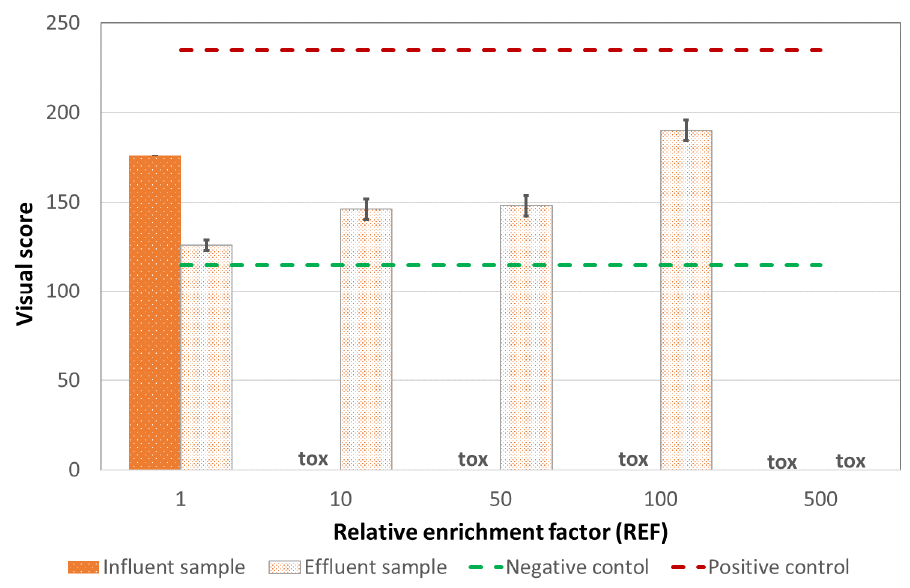
Figure 3. Visual classification of DNA damage, expressed as “visual score”, at increasing concentration. The error bars show the standard deviation.